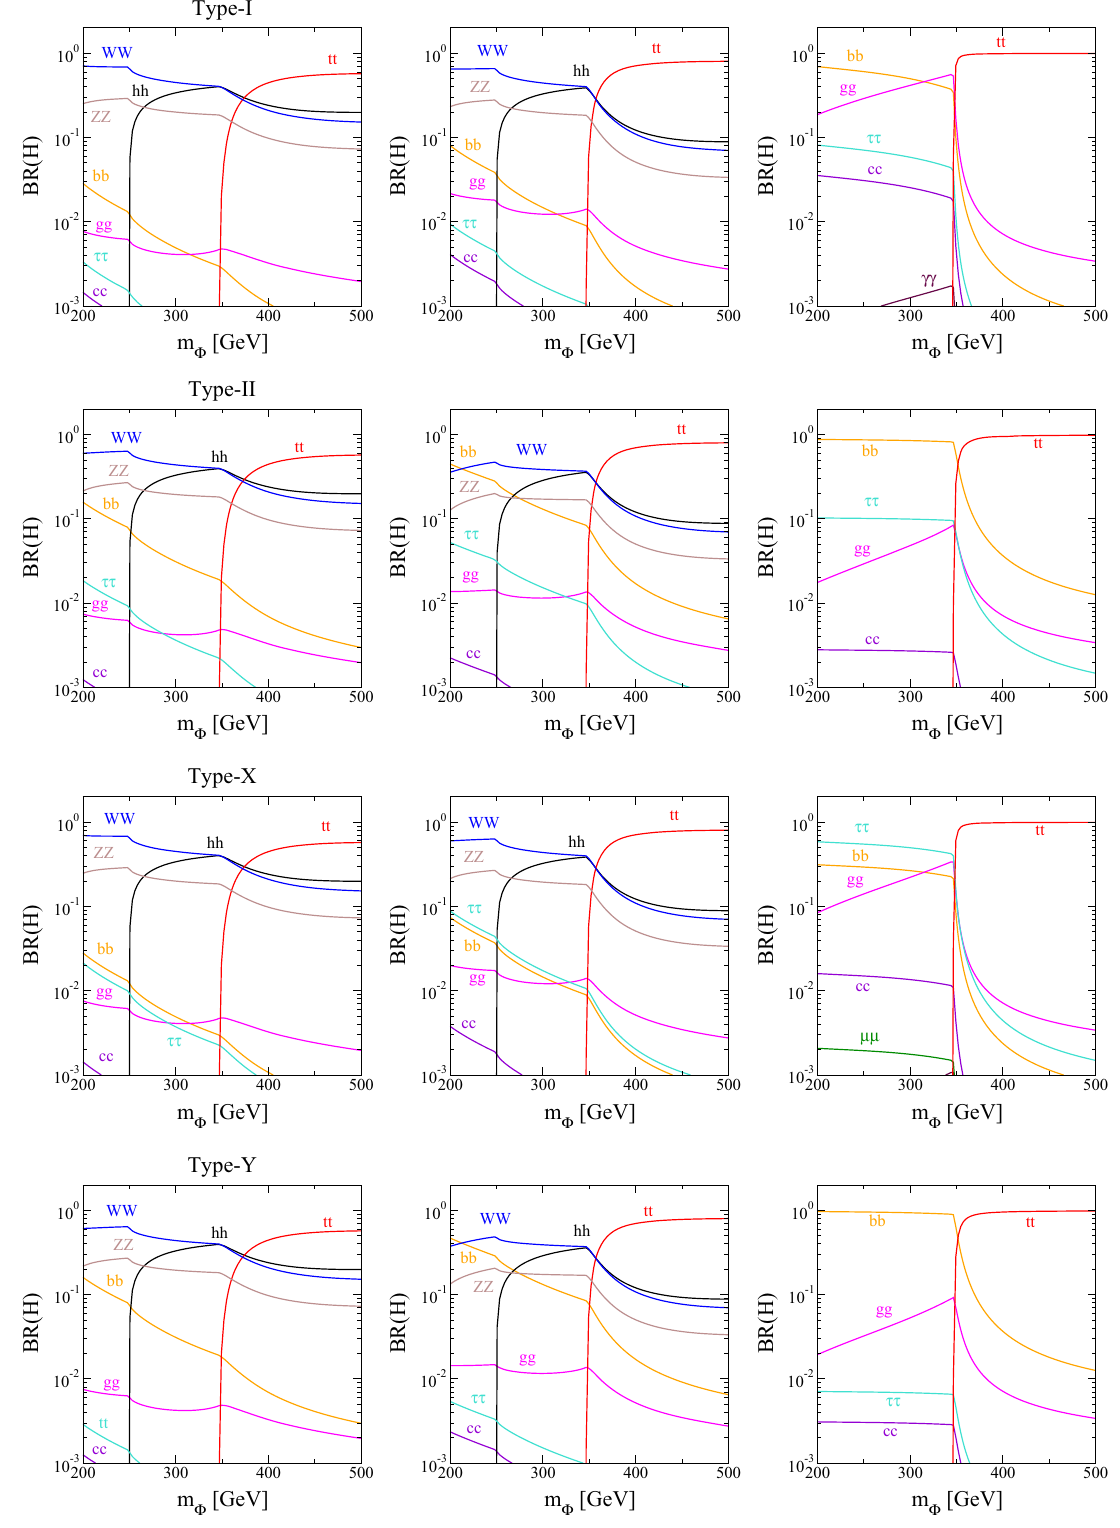
= m = m ) with tan β = 2 and M = 0 . 8 × m H ± H A